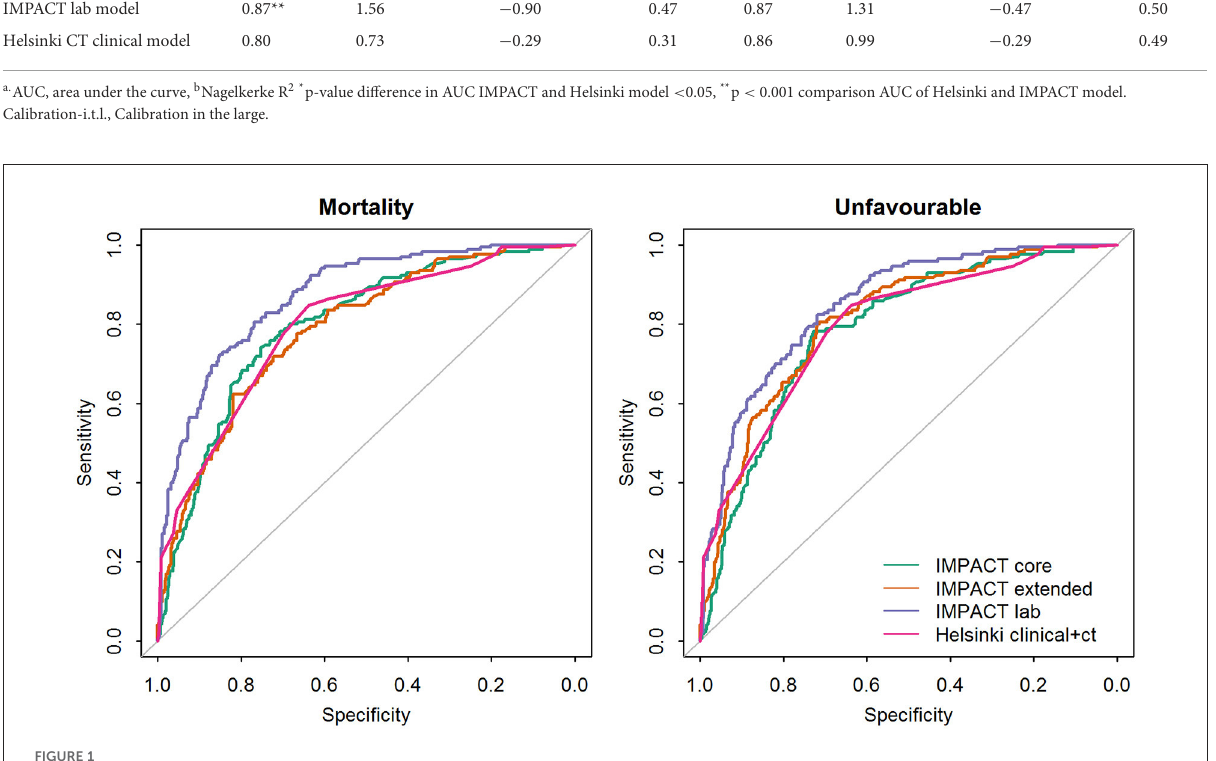
FIGURE1 Comparison of the areas under the receiver operating characteristic curve (AUC’s) between the prognostic models validated on the PLANC